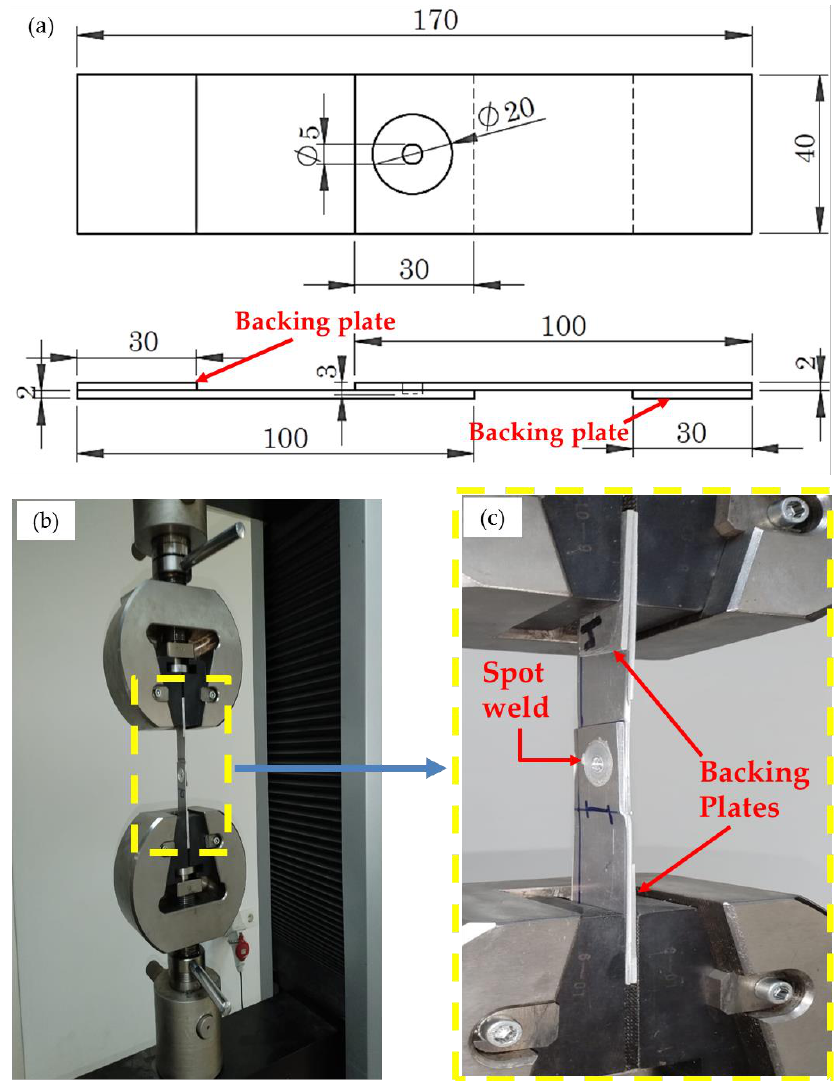
Figure 3. ( a ) Schematic of the spot-welded tensile shear test specimen; ( b ) picture of the specimen during the tensile shear test; and ( c ) high-magnification picture.